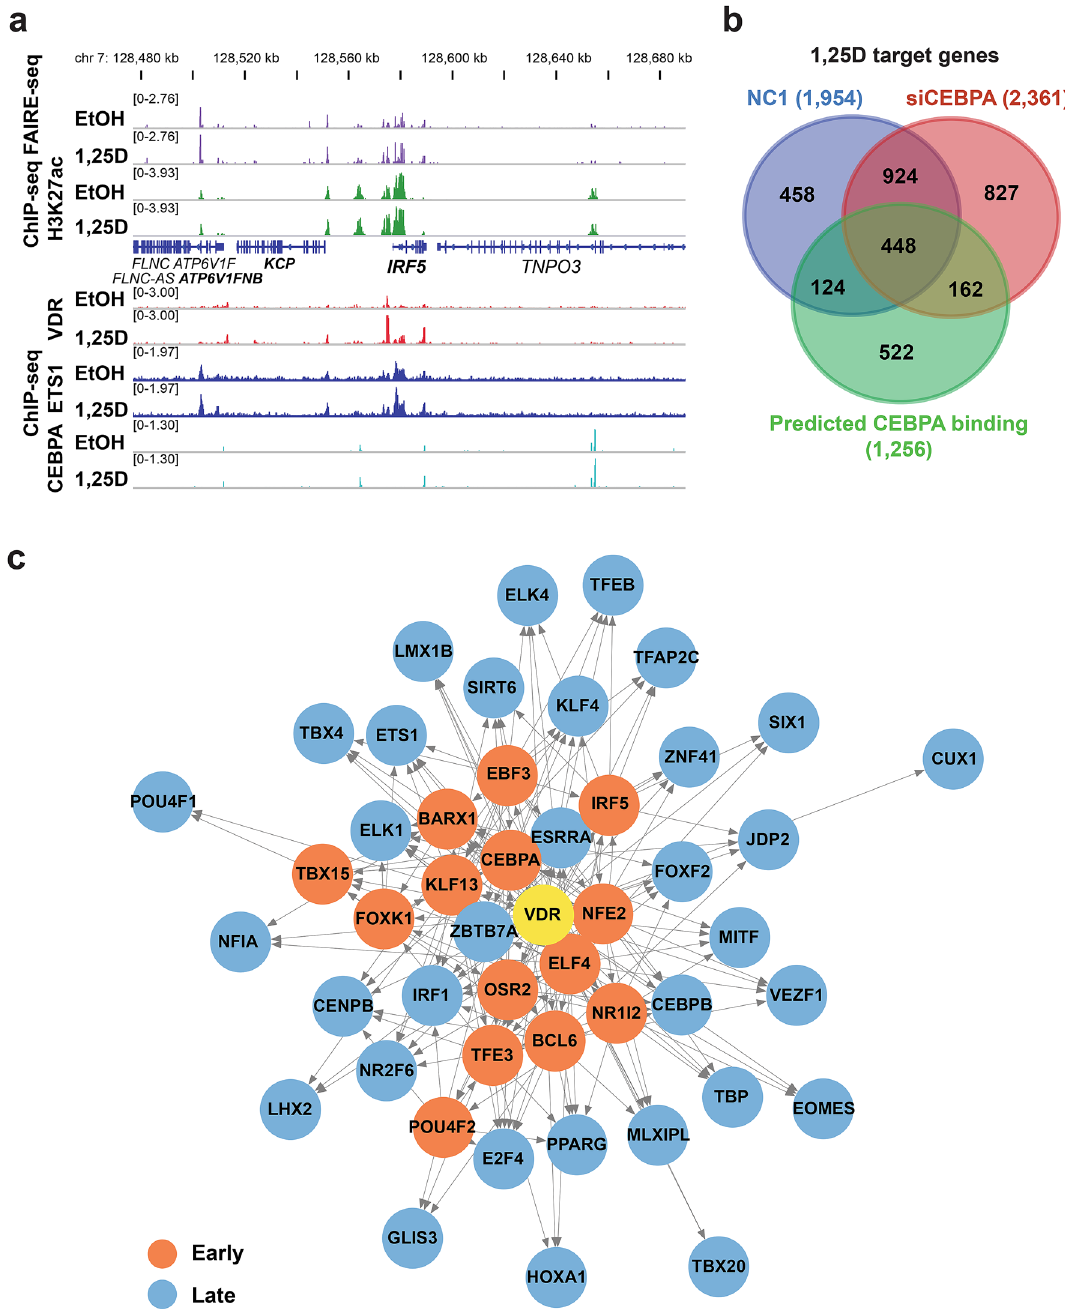
Figure 5. Higher level of regulation by secondary vitamin D responses on transcription factors. The predicted binding of VDR, ETS1 and CEBPA 13 to the gene loci of the primary VDR target IRF5 was confirmed by ChIP- seq assays. The binding occurred in open chromatin 15 and co-located with the active enhancer mark H3K27ac 12 ( a ). Please note that for the VDR ChIP-seq tracks 11 the scale has been adapted to visualize medium-sized peaks, meaning that the summit of the strongest peak in both loci is cut. Intersects of the 1,25(OH) 2 D 3 regulated genes identified from a previously published RNA-seq dataset in THP-1 cells with CEBPA knockdown 13 with the predicted binding of CEBPA close to these genes ( b ). The directional network denotes which early primary VDR targeted transcription factors were predicted to bind at the gene loci of late primary VDR target transcription factors. All transcription factors shown were predicted to be bound at their gene loci by VDR ( c